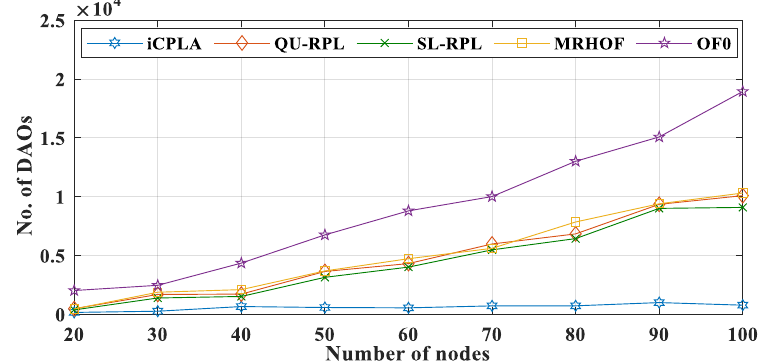
Figure 10. Comparison of number of DAO control messages between i CPLA, QU-RPL, SL-RPL, MRHOF, and OF0 with 𝛼 = 0.3 and 𝛽 = 0.7 in a network of 20 to 100 nodes.